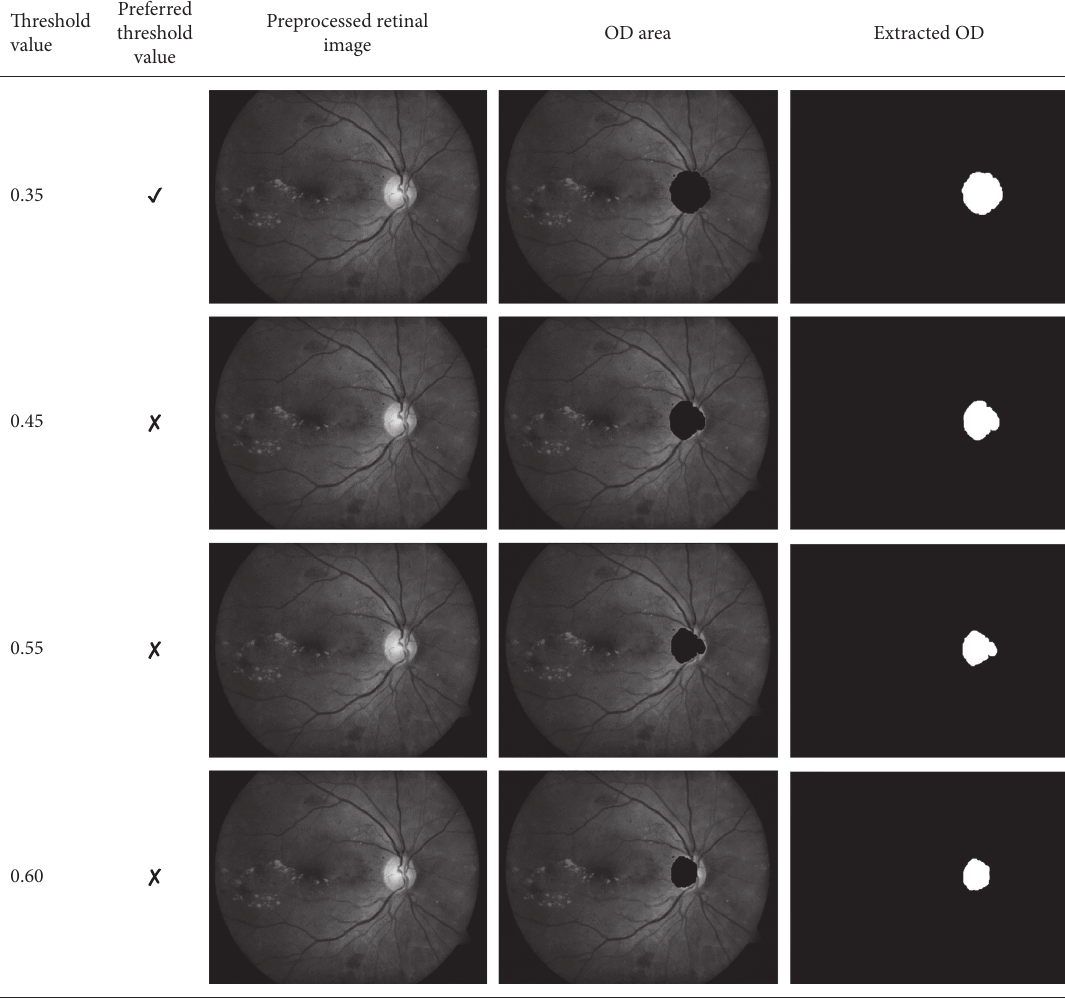
Figure 4: Effects of threshold values on OD